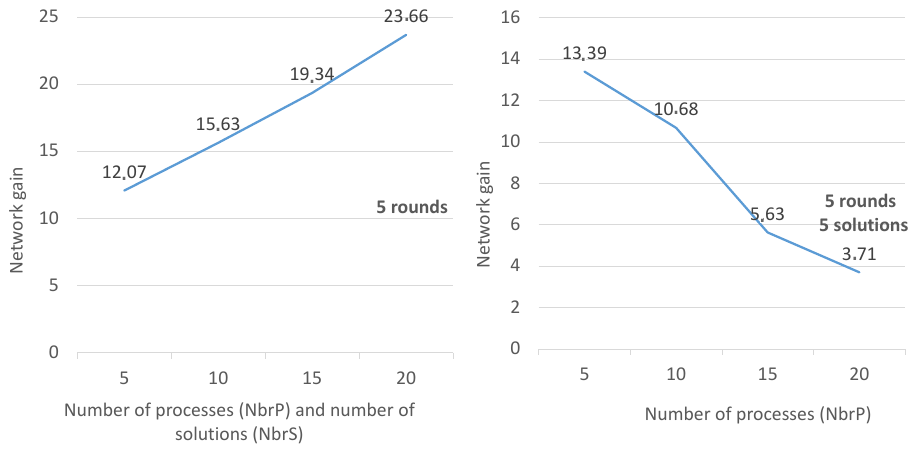
Figure 3. The influence of NbrP for fixed